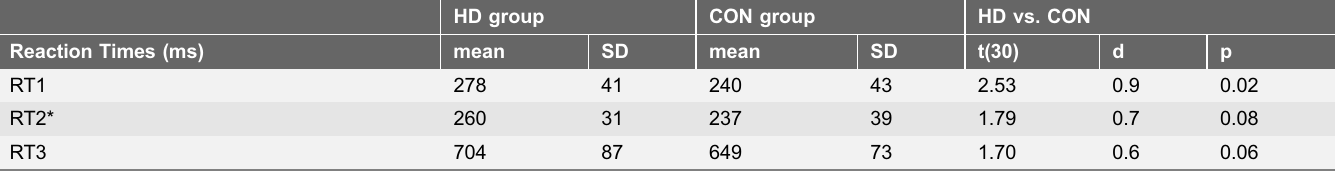
Table 2. Reaction times of behavioural tasks after scanning. HD group CON group HD vs.